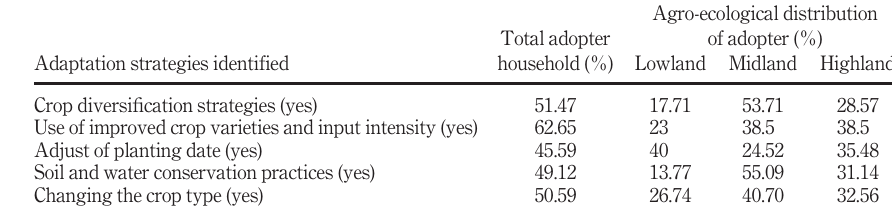
Adaptation strategies identified